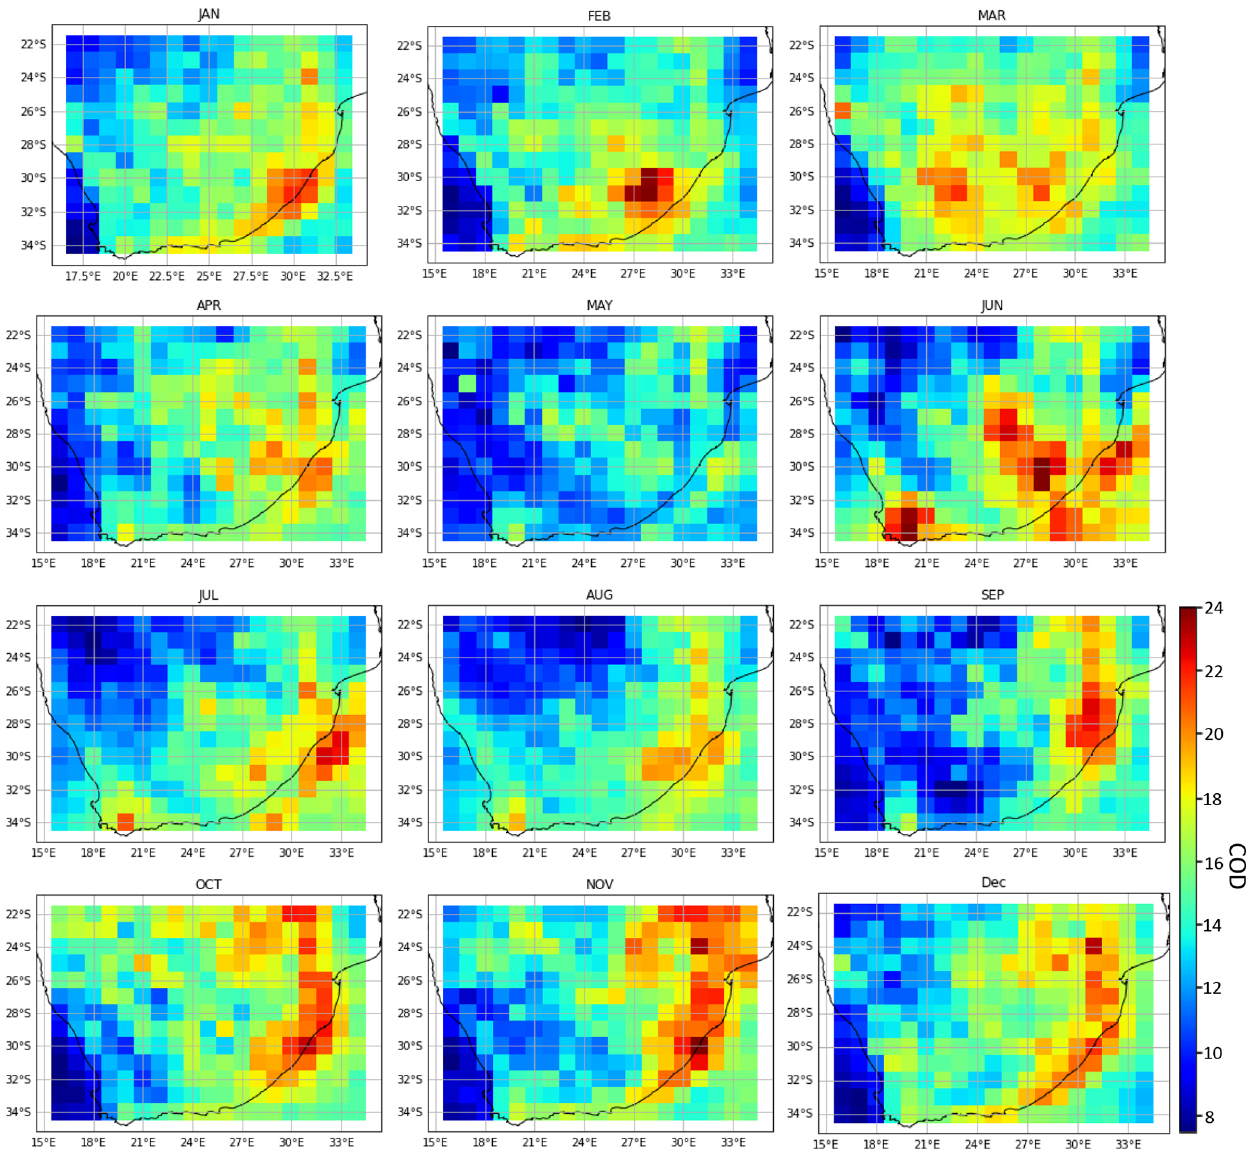
Figure 7. Average cloud optical depth (COD) over South Africa from MODIS data for 10